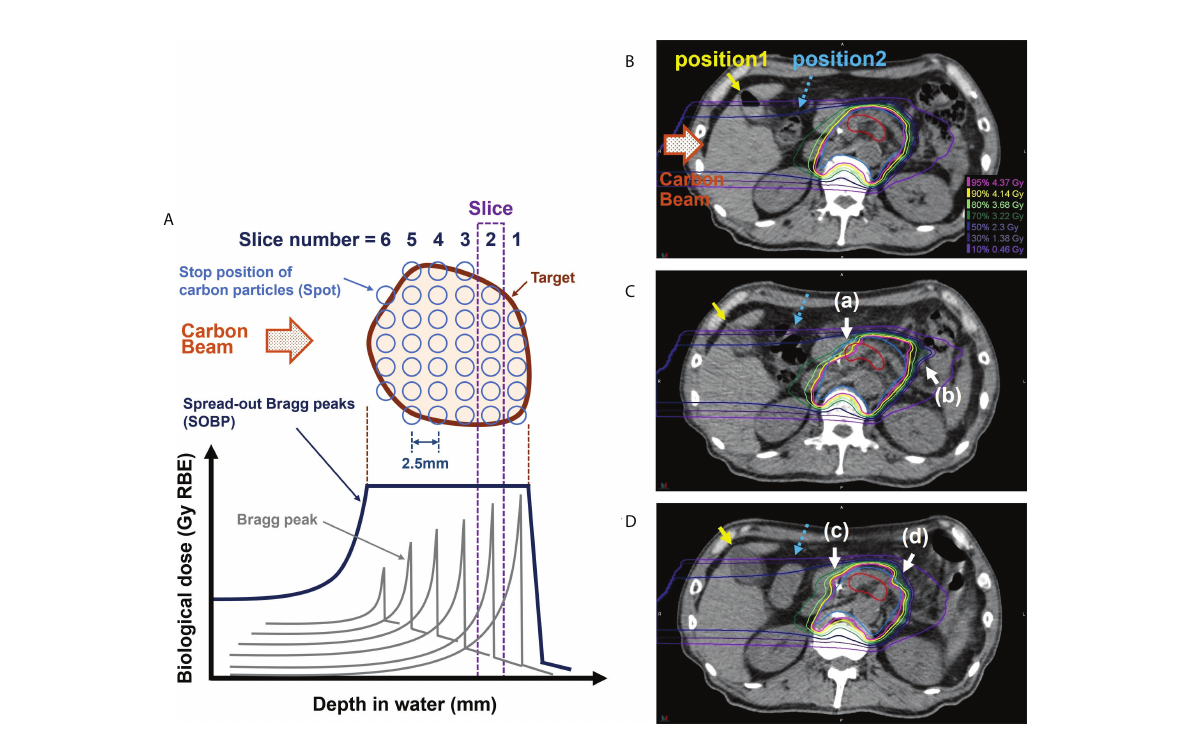
FIGURE 1 Effect of gastrointestinal gas (G-gas) on dose distribution in scanning carbon-ion radiotherapy for pancreatic cancer. (A) An illustration of the formation of the spread-out Bragg peaks (SOBP). (B) The dose distribution in the treatment planning computed tomography (CT) image in a sample case. (C) The dose distributions in the in-room CT images taken during the fi rst irradiation. (D) The dose distributions in the in-room CT images taken during the ninth irradiation. The treatment of pancreatic cancer is conducted by performing irradiation in 12 fractions. During pancreatic cancer treatment, the stops of the carbon particles are determined at 2.5 mm water depth intervals. The red and blue contours indicate the gross tumor volume (GTV) and clinical target volume (CTV), respectively. The carbon beam direction is from the left side in each fi gure